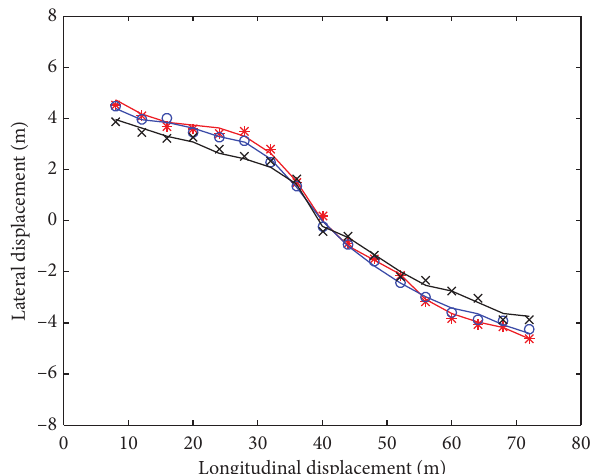
Figure 4: Actual test data and simulation data of right lane